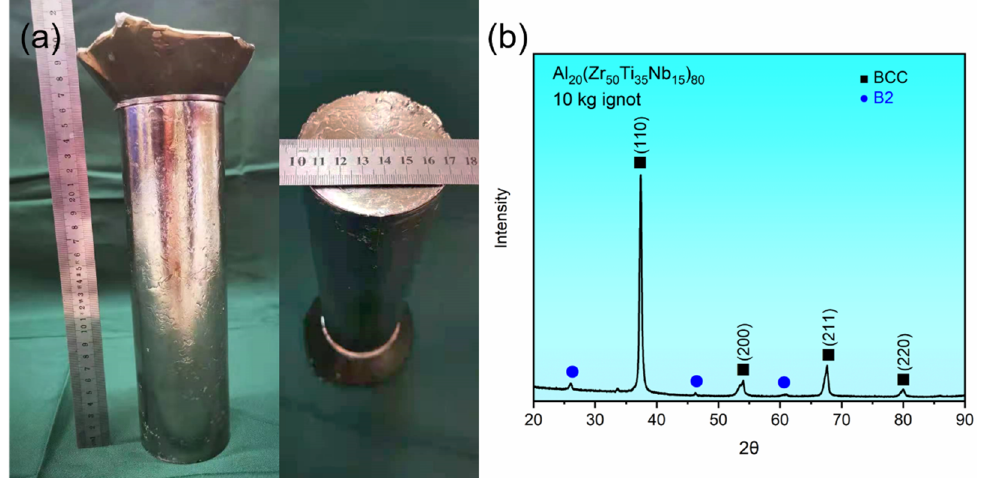
Figure 7. ( a ) The 10 kg ingot of Al 20 (Zr 50 Ti 35 Nb 15 ) 80 alloy, ( b ) the XRD pattern of the